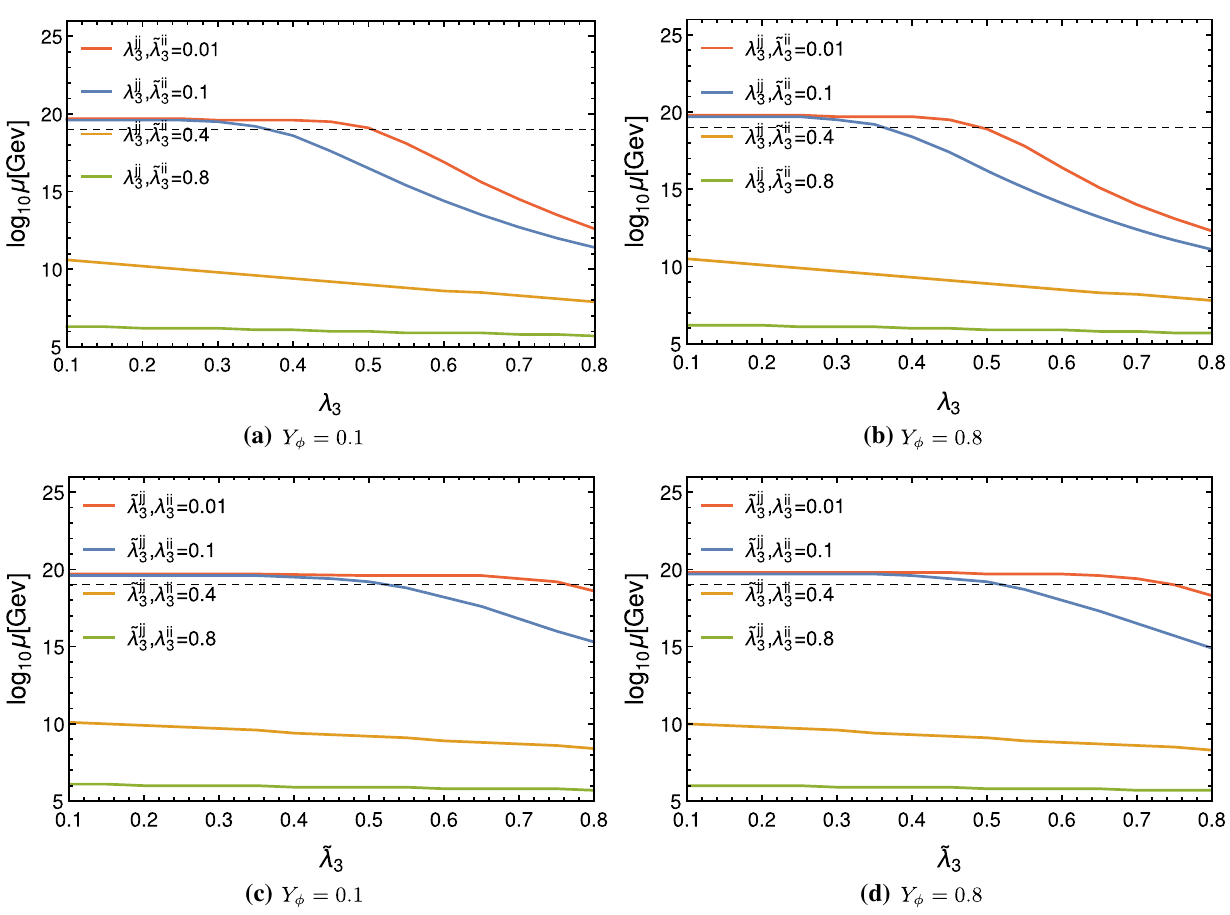
Fig. 5 Variation in leptoquark-Higgs quartic coupling λ 3 and (cid:2) λ 3 for triplet leptoquark S 3 with the perturbative scale. For the plots in the first row, λ 3 variation is considered for any particular generation of lep- toquark, and the same for the remaining generations are denoted by λ jj . The other leptoquark-Higgs quartic couplings (cid:2) λ ii 3 leptoquark generations. Similarly, for the plots in the second row, the variation in quartic coupling (cid:2) λ 3 for any particular leptoquark generation